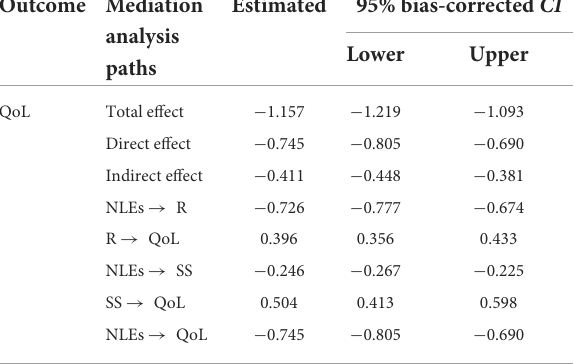
TABLE 3 The mediating effect of NLEs on QoL through R and SS.